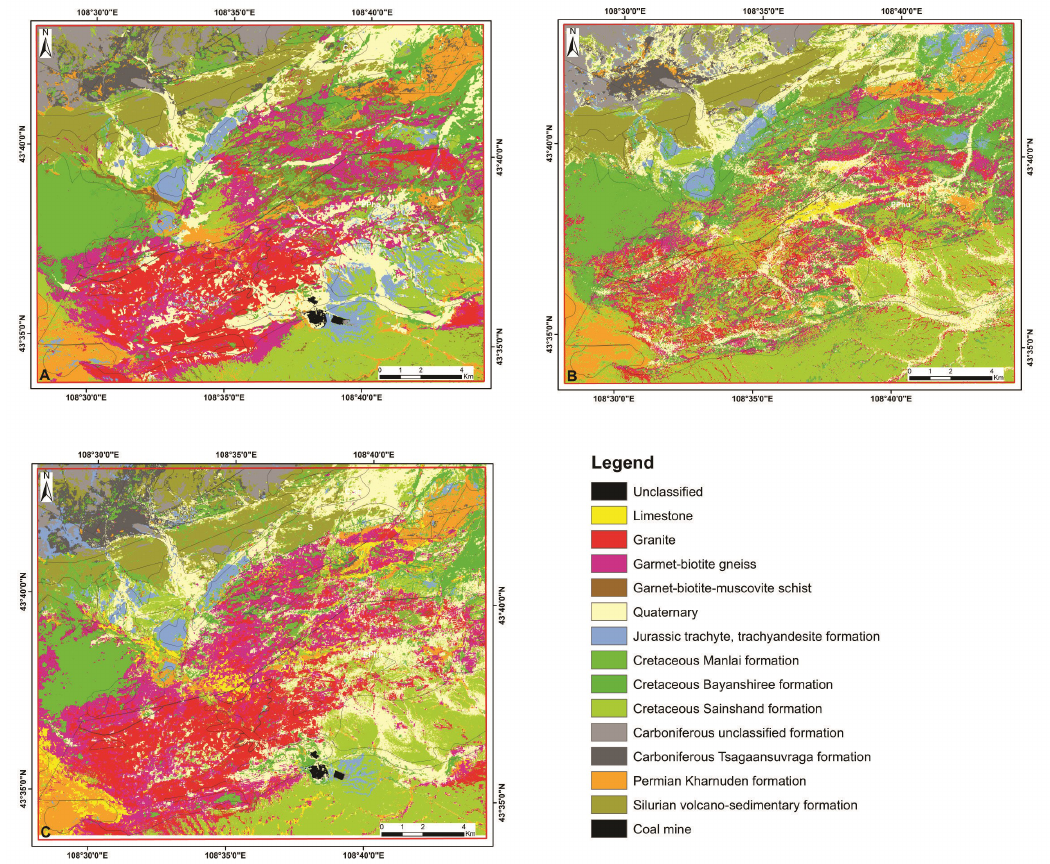
Fig. 13. Results of SVM classification A) Landsat OLI; B) ASTER; C) Sentinel 2A